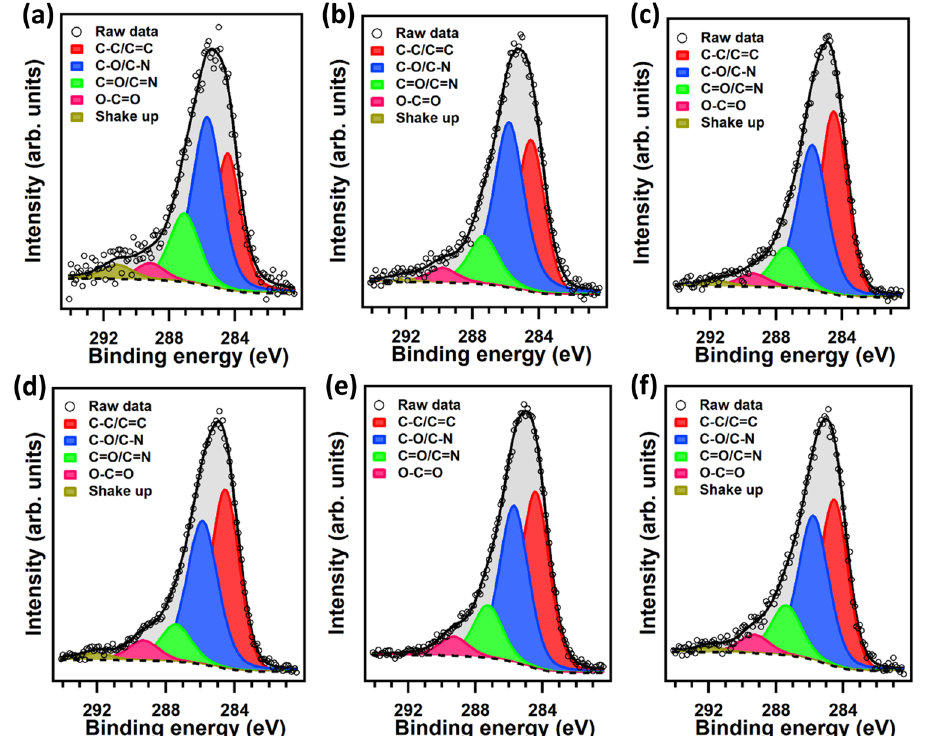
Fig.5|XPScharacterizationofmodi fi edHNT-PDAsamples. XPSspectraoftheC1 s corelevelregionforHNT-PDAafter a 5min, b 15min, c 30min, d 60min, e 120min, and f 240min of polydopamine